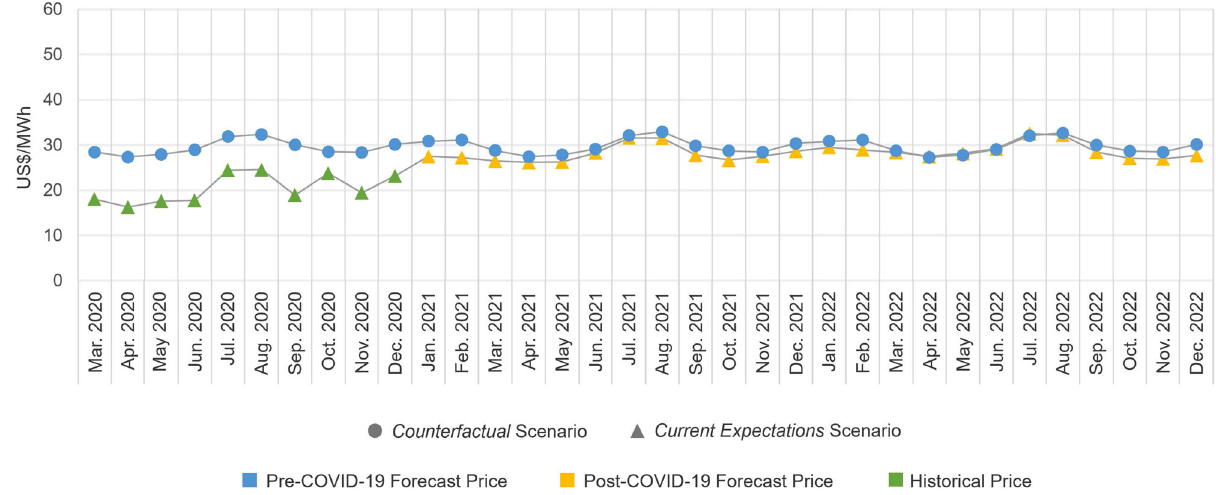
Fig. 5 Generation capacity-weighted monthly average electricity market prices, counterfactual scenario and current expectations scenario. We show monthly average prices across all electricity market regions weighted by the coal generation capacity in each region. Circles show counterfactual estimates and triangles show estimates under current expectations. Blue data points re fl ect counterfactual price forecasts. Yellow data points re fl ect current expectations price forecasts. Green data points re fl ect actual historical